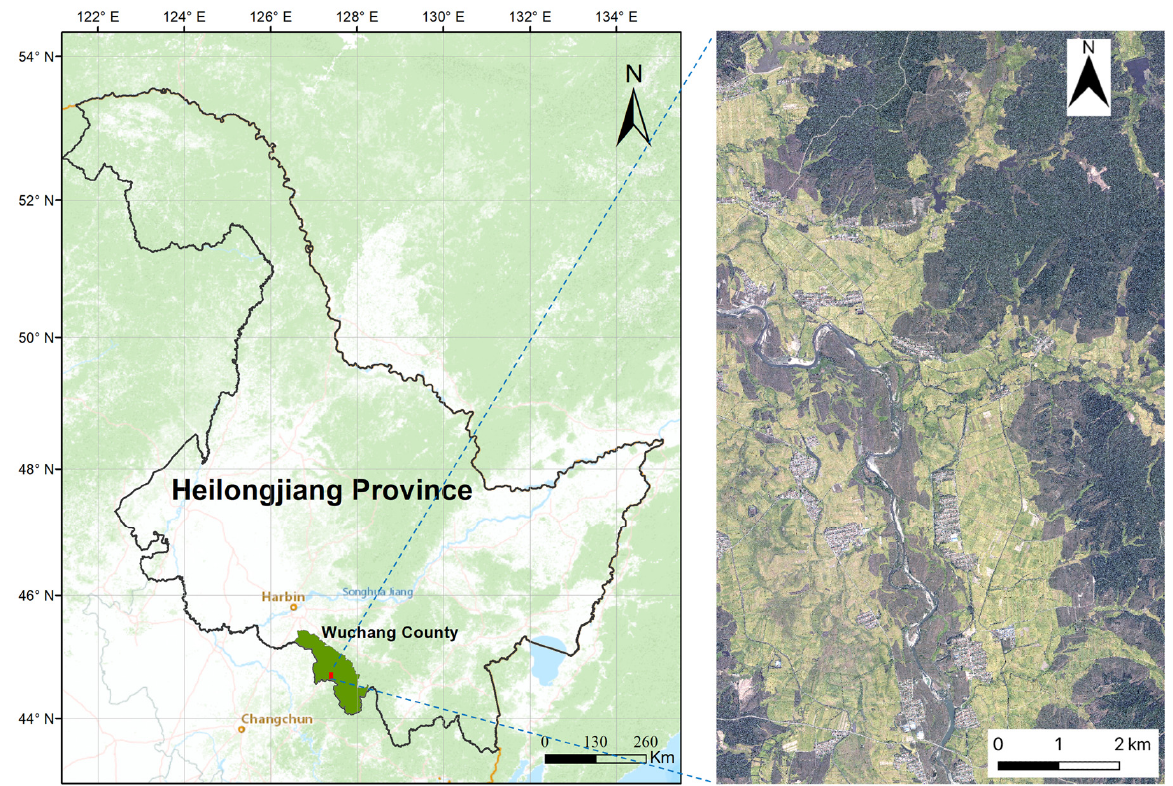
Figure 1. The location of the study area ( left ) and its true-color RGB composite ( right ) from CNES/Airbus Pléiades satellite imagery captured in September 2018.